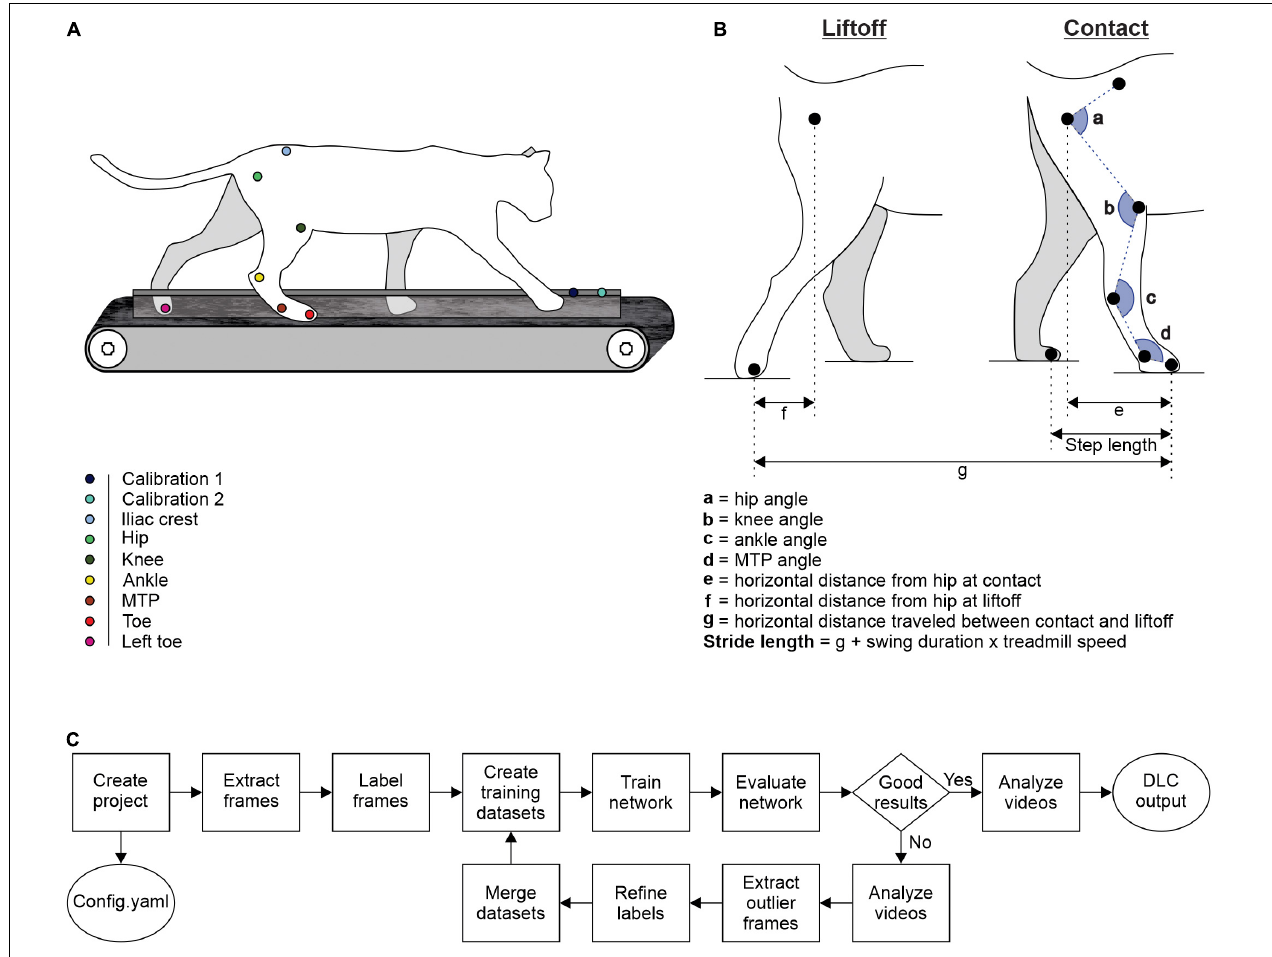
FIGURE 1 | Experimental design and measured variables. (A) Reflective markers were placed on bony landmarks. The cat was then placed on a split-belt treadmill for video recordings during locomotion. (B) Lengths, distances, and angles measured at contact and at liftoff. (C) Schematic diagram summarizing DLC steps (adapted from Nath et al.,